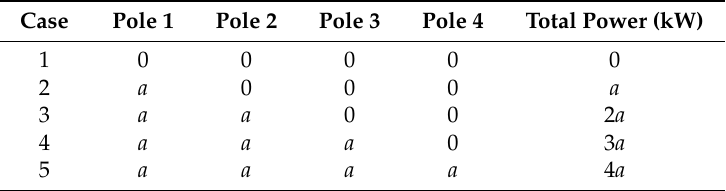
Table 1. The total power of 4 traditional poles in 5 cases.